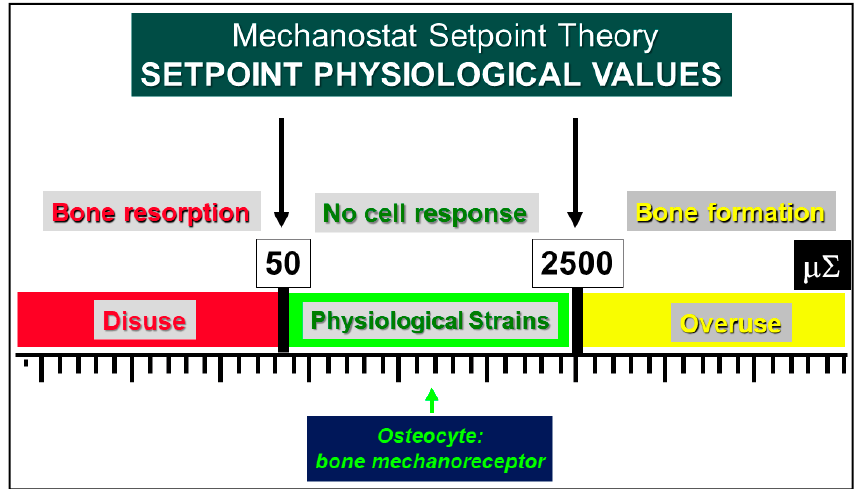
Figure 9. Schematic illustration of Frost’s Mechanostat Setpoint Theory. The setpoint values are expressed in microstrains ( μ∑ ) and the bone mechanoreceptors (osteocytes) are activated only when the physiological setpoints are exceeded. In the “disuse” window, bone is lost owing to increased resorption. In the “overuse” window, bone is gained owing to increased bone formation.